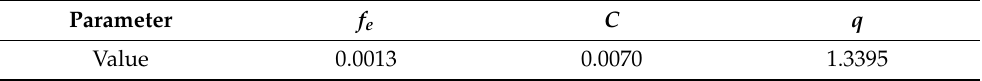
Table 3. Parameters related to the precipitation fraction during stress relaxation at 900 ◦ C.